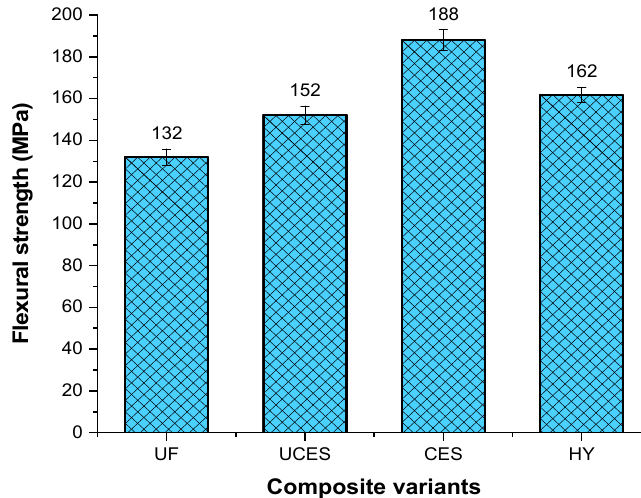
Figure 7. Flexural strength comparison of composite variants.